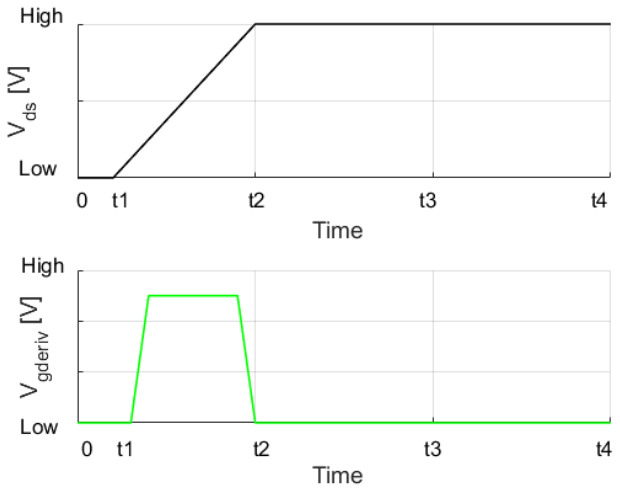
Figure 18. Schematic diagram of a derivative circuit.